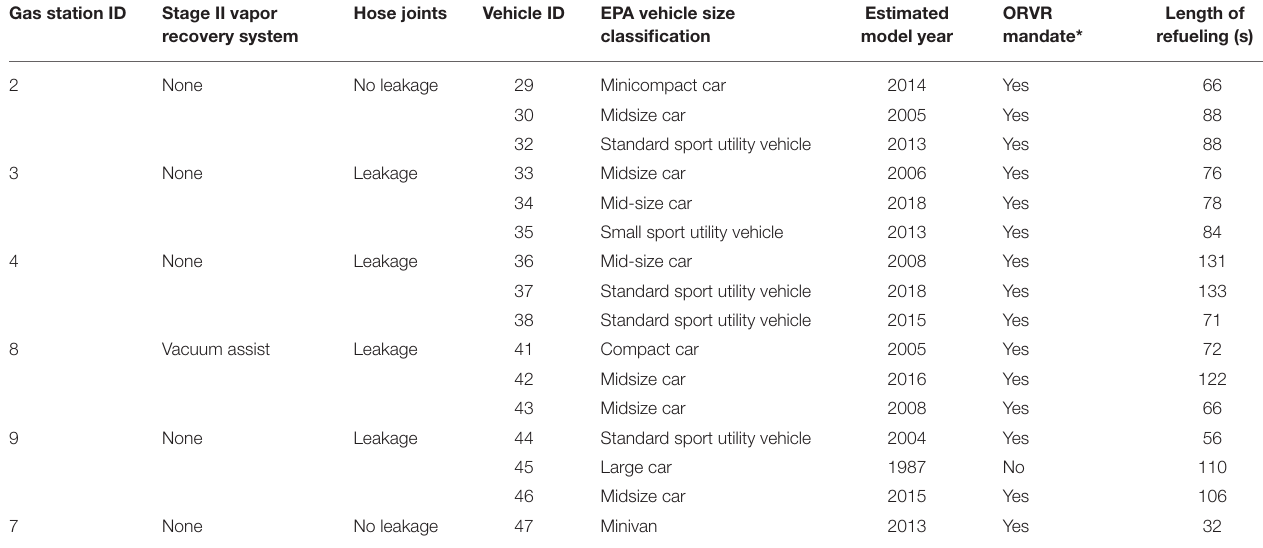
TABLE 1 | Characteristics of gas stations and vehicle refueling events. Gas station